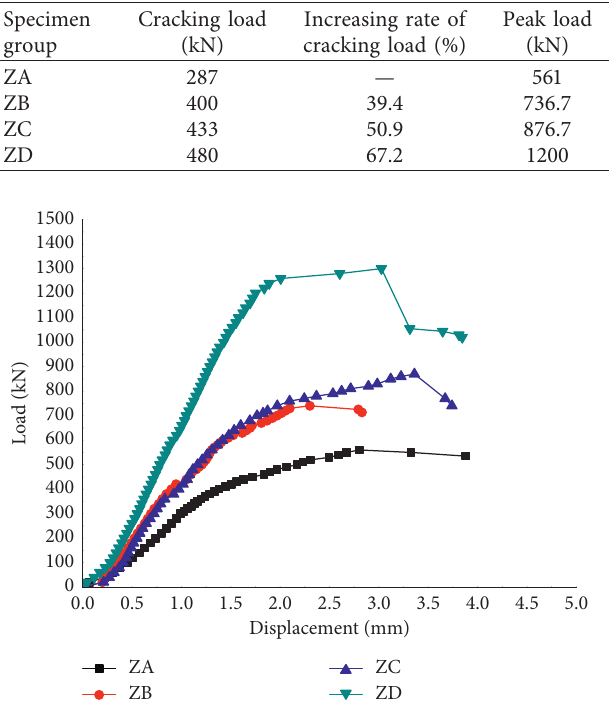
Figure 4: Layout of strain gauges: (a) ZB and (b) ZC and ZD. Table 5: Test results average.